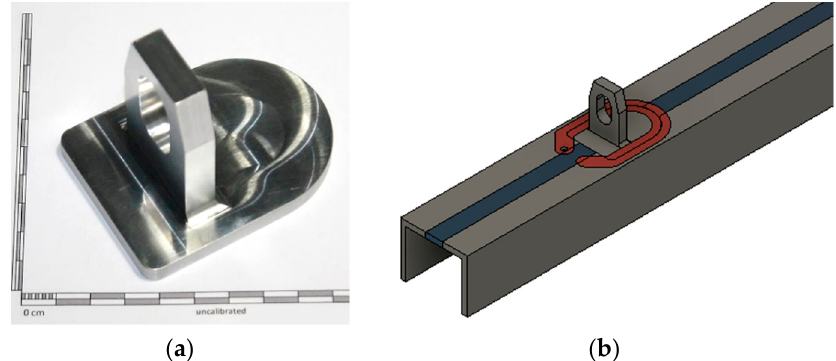
Figure 3. Bracket insert. ( a ) Machined piece and ( b ) weld path (red).